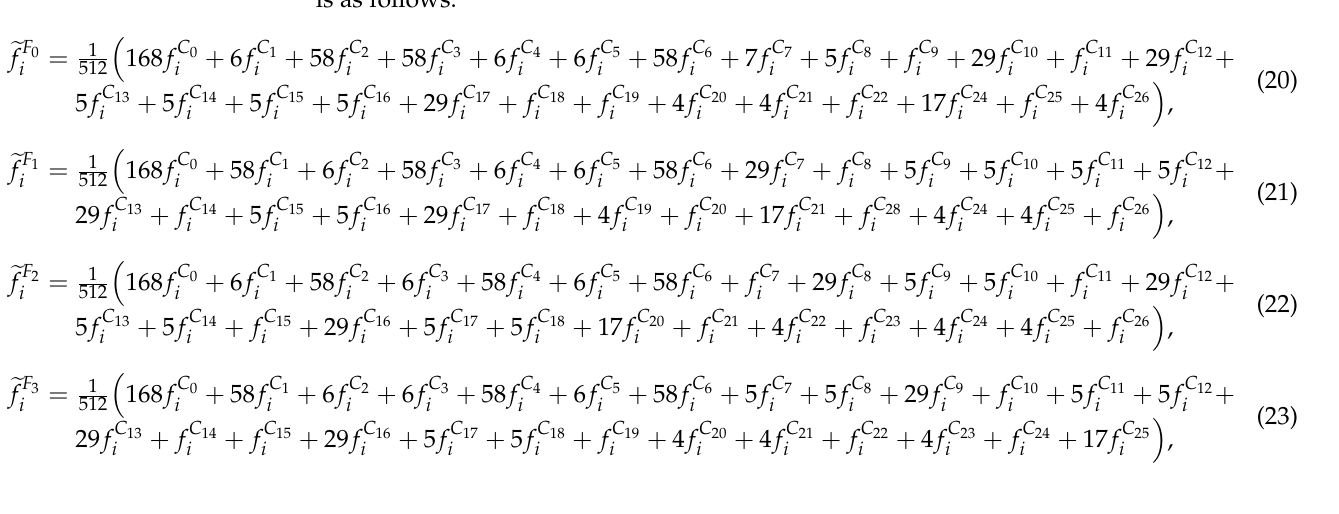
(𝑖 = 0,1, … ,7) are obtained by interpolat- (cid:3036) (i = 0, 1, 2,..., 26). The specific for- (cid:3036)